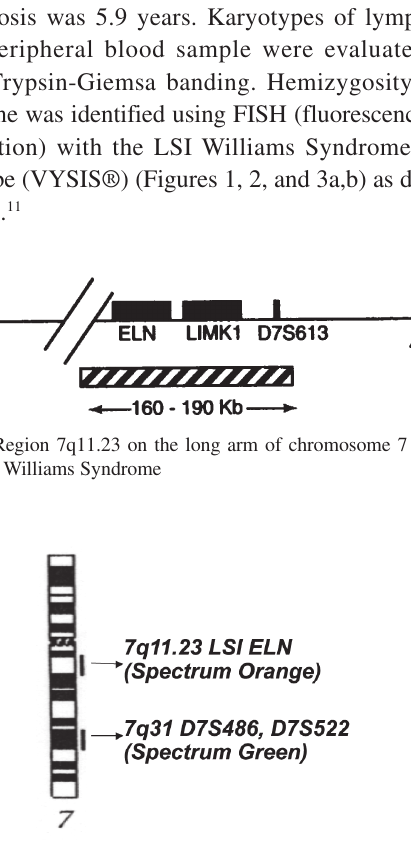
Figure 2 - Chromosome 7 ideogram: regions of probe hybridization